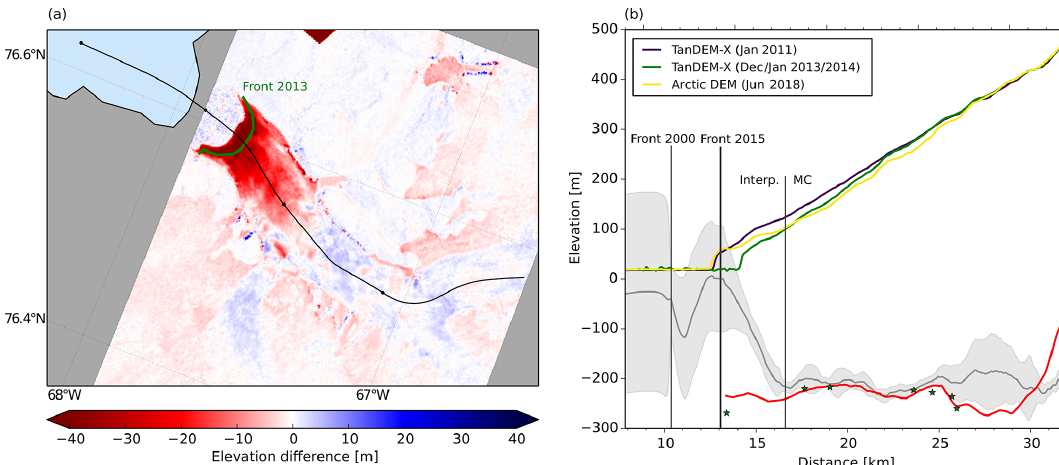
Figure 13. (a) Difference between ice surface elevations from two TanDEM-X observations (December/January 2013/2014 minus January 2011). (b) Profiles of bedrock topography from BedMachine (grey) and CReSIS (red) along the ground track of a flight path from May 2014 (Paden et al., 2019). Stated uncertainties for the BedMachine data set (Morlighem et al., 2017) are indicated by the grey error band. Green stars mark the elevations from independent CReSIS measurements at the intersections of the ground tracks. Vertical lines mark the front positions of 2000 and 2015 and the boundary between the areas where BedMachine applied interpolation and a mass conservation approach (MC), respectively (Morlighem et al., 2017). Profiles of glacier surface height at different times are also shown. Panel (a) also shows the profile location (black line starting at the glacier front position of 1916 and black circles every 10km along the profile) and the front position of December/January 2013/14 (green line).